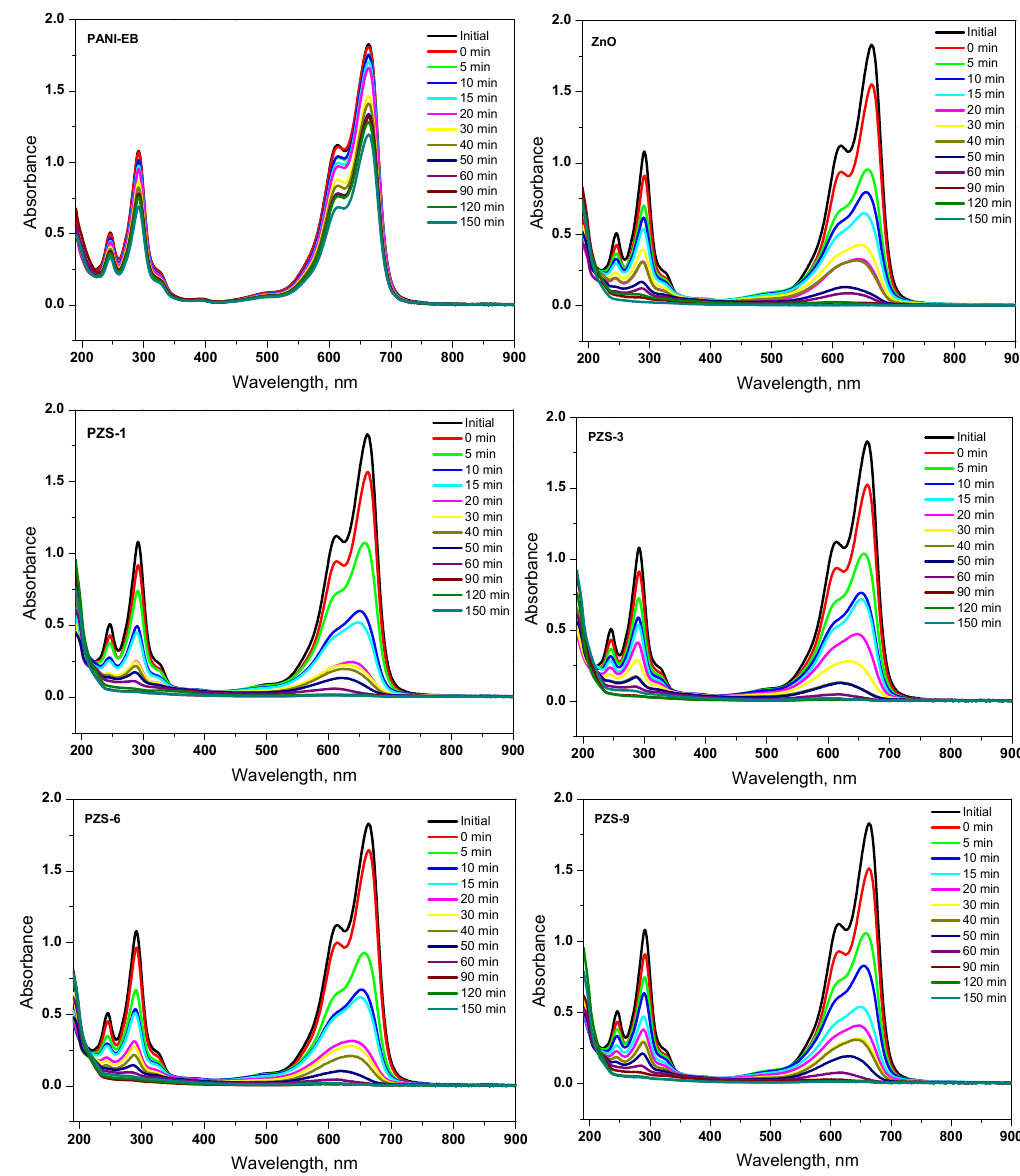
Figure 8. UV-vis absorption spectra of MB using PANI-EB, ZnO and PZS composites.